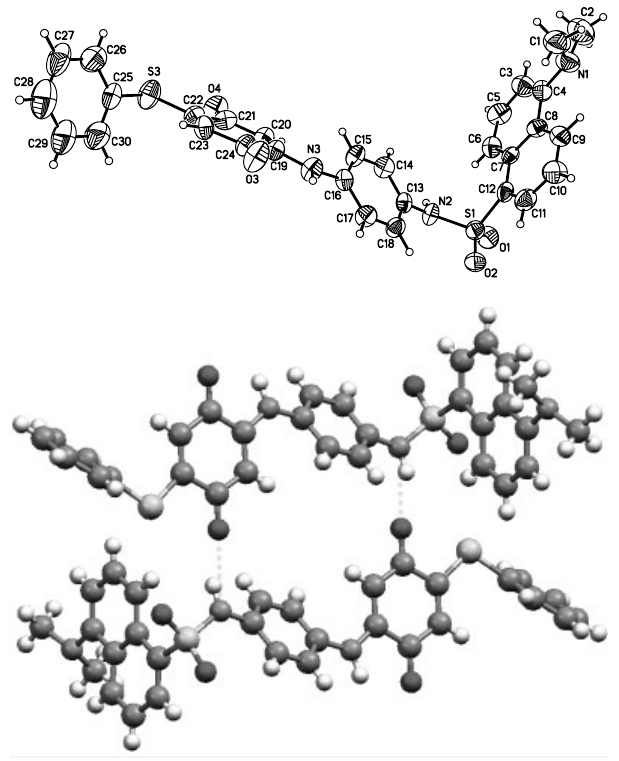
figure. The S -phenyl ring has a C25–S3–C22 angle of 103.8° with the quinone ring. The C19–N3–C16 angle between the p -phenyl- ene diamine and quinone ring is 128.2°. The torsion angle